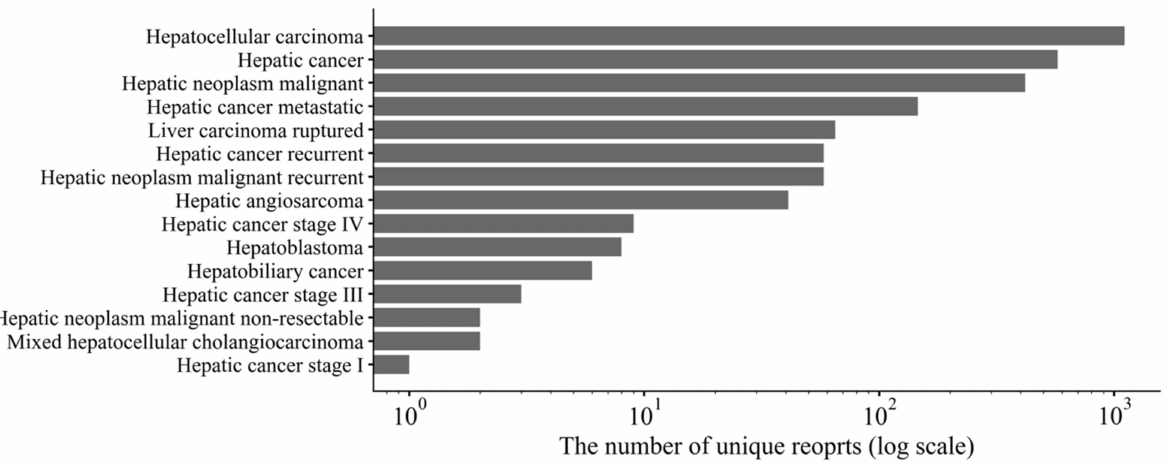
Figure 2. Numbers of unique records of MedDRA preferred terms (PTs) related to liver malignant